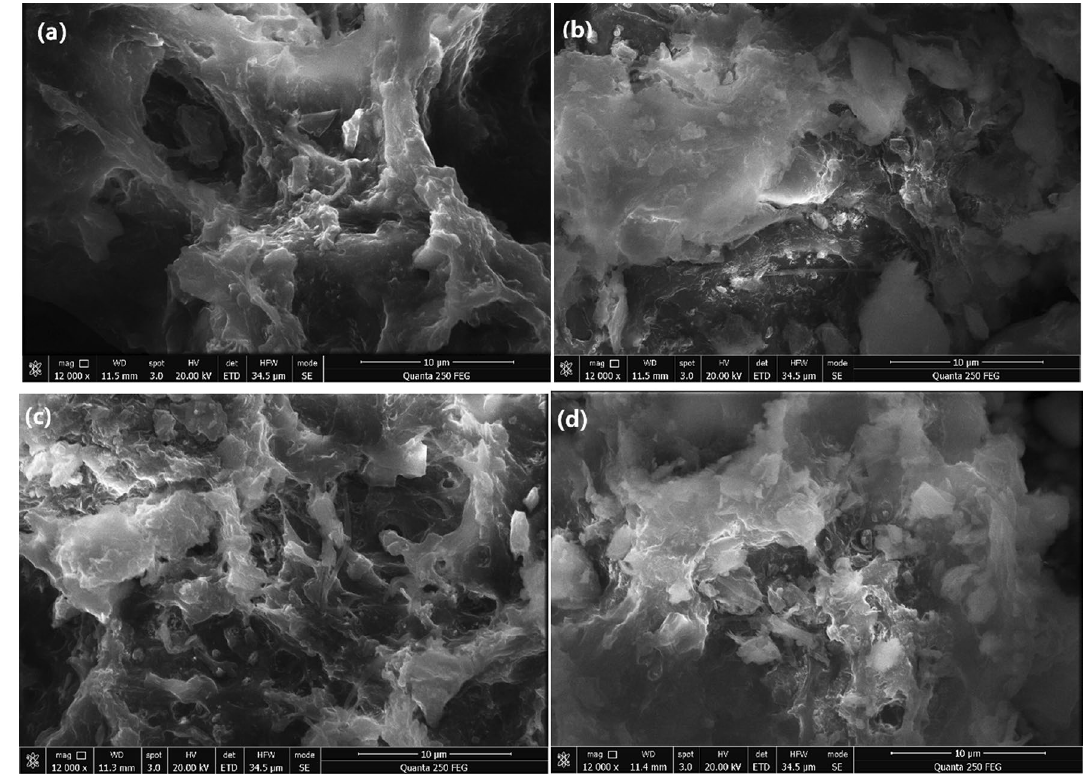
Figure 7. SEM images of sludge cakes: ( a ) raw sludge and conditioned by ( b ) ATP, ( c ) St-CTA, and ( d ) St-CTA in conjunction with ATP at respective optimal dose, that is, St-CTA is 16.00 mg/gTSS and ATP is 14.00 kg/m 3